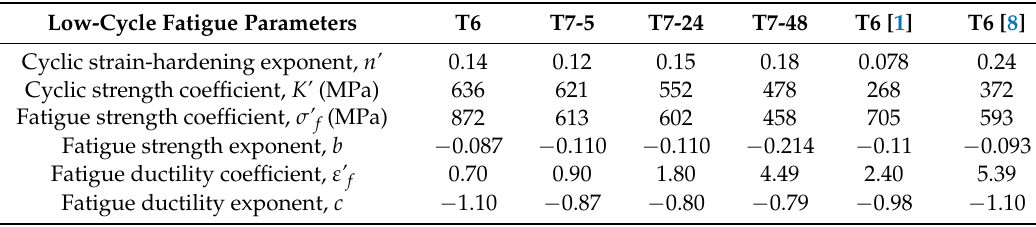
Low-cycle fatigue (LCF) parameters estimated for 6061 aluminum alloys under various